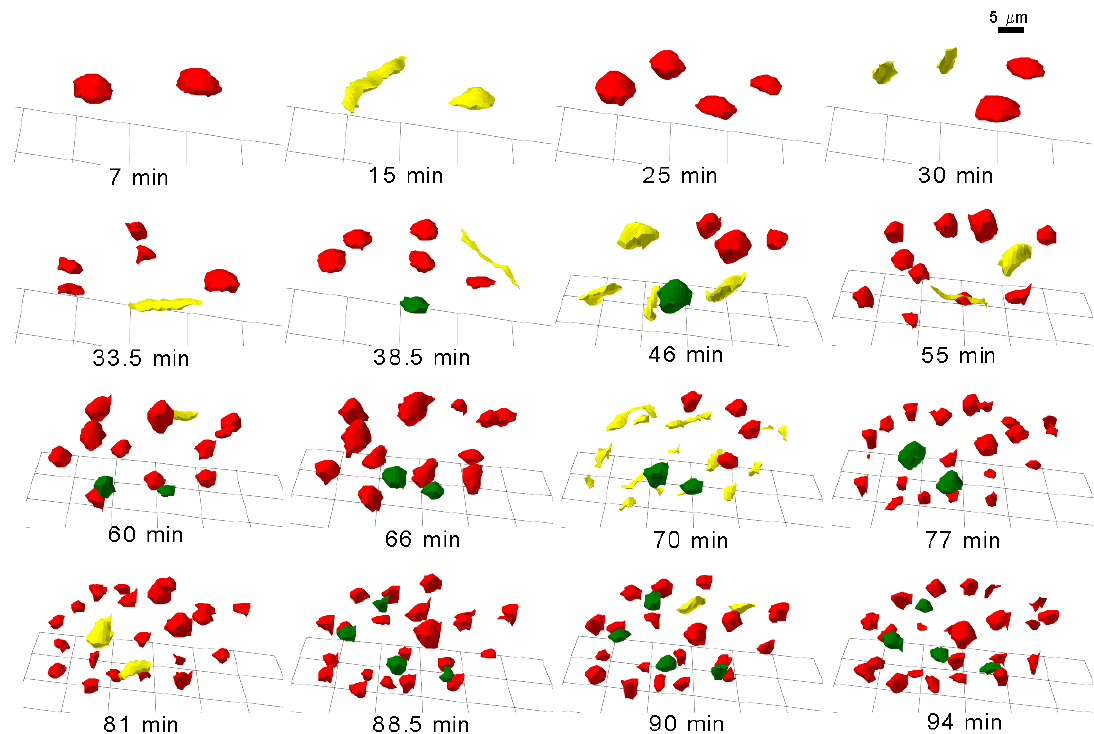
FIGURE 9 . 3D-DIASemb provides reconstructions of nuclei during C. elegans embryogenesis. Interphase nuclei are color-coded red and mitosing nuclei yellow. In this sequence MS-derived nuclei are color-coded green. When undergoing mitosis, MS nuclei are also color-coded yellow (see [54] for details).